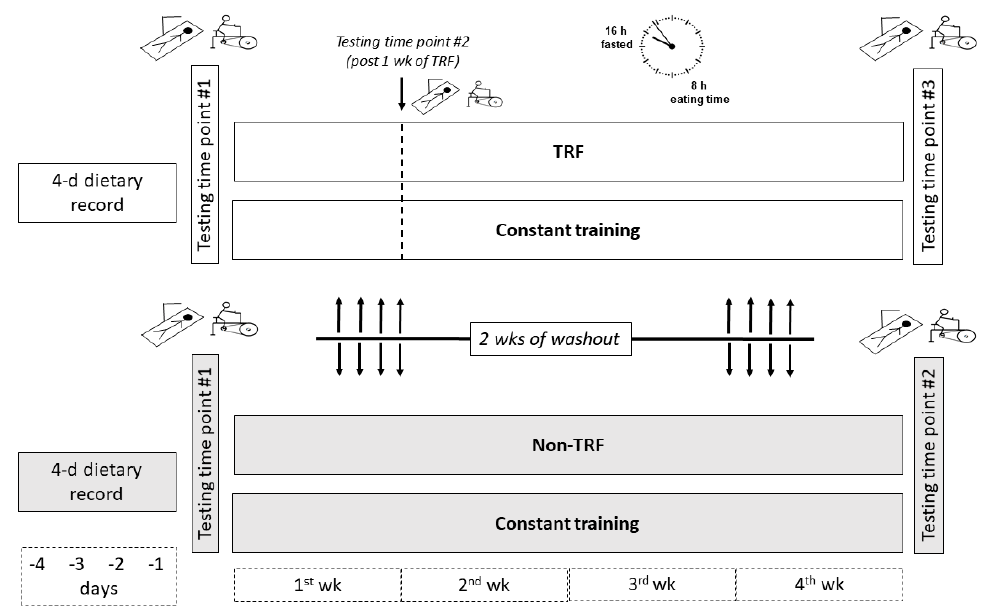
Figure 1. Schematic representation of the study protocol.